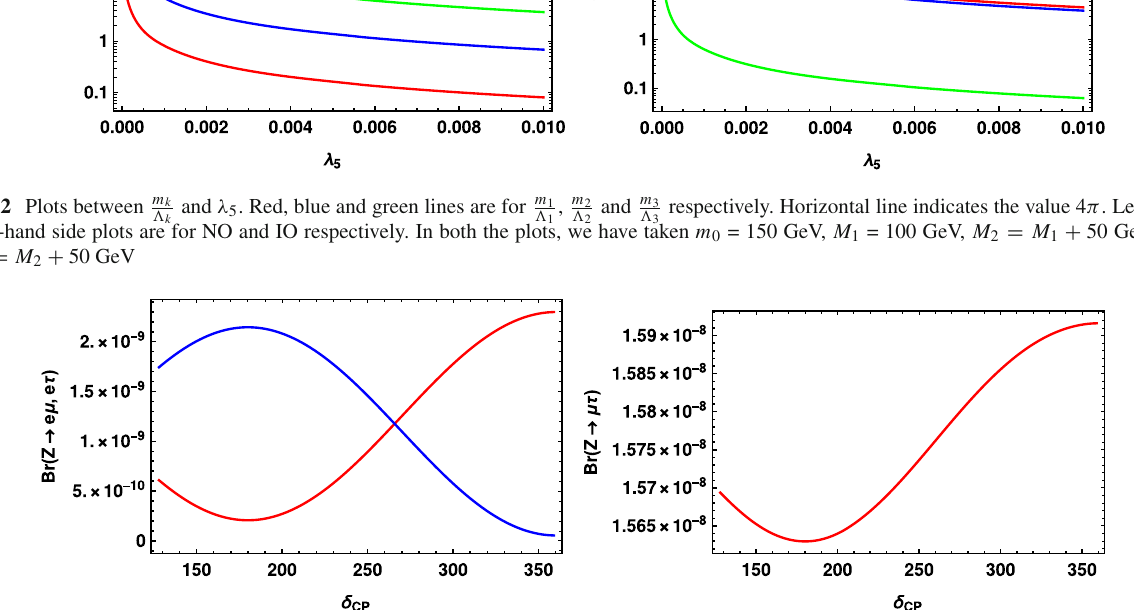
Fig. 3 Plots between Br ( Z → (cid:2) α (cid:2) β ) and δ CP for the case of NO, without applying the constraints due to non-observation of (cid:2) α → (cid:2) β γ . Numerical values for neutrino masses are taken from Eq. (25). Neutrino